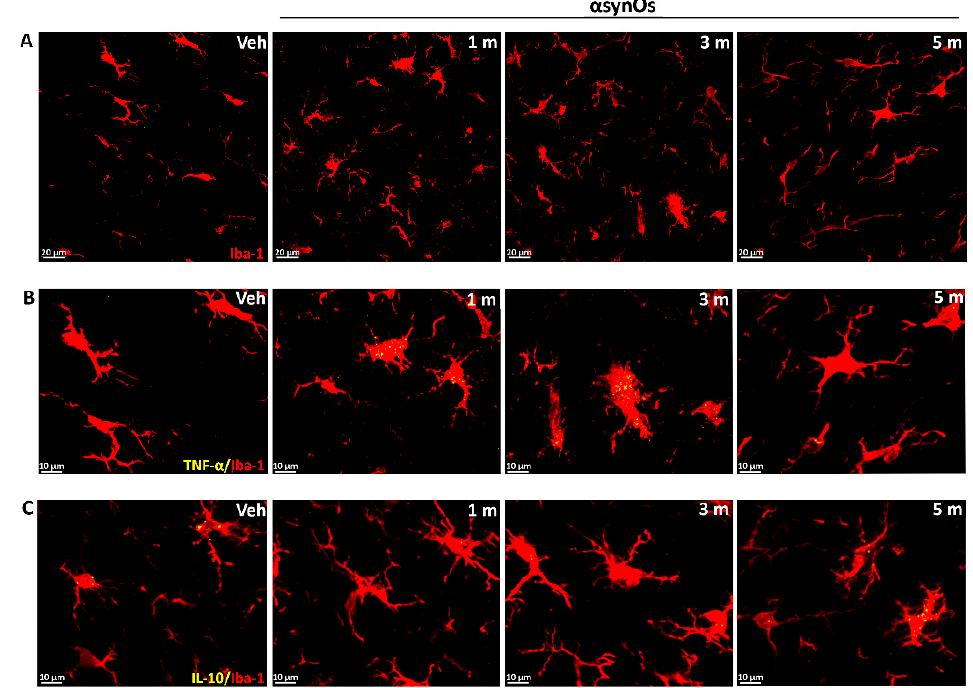
Figure 5. Representative images of Iba-1 (red, magnification 63×) ( A ), TNF- α (yellow) ( B ), and IL-10 (yellow) ( C ) colocalized with Iba-1+ cells (magnification 63×). 2.3.2. Cytokines